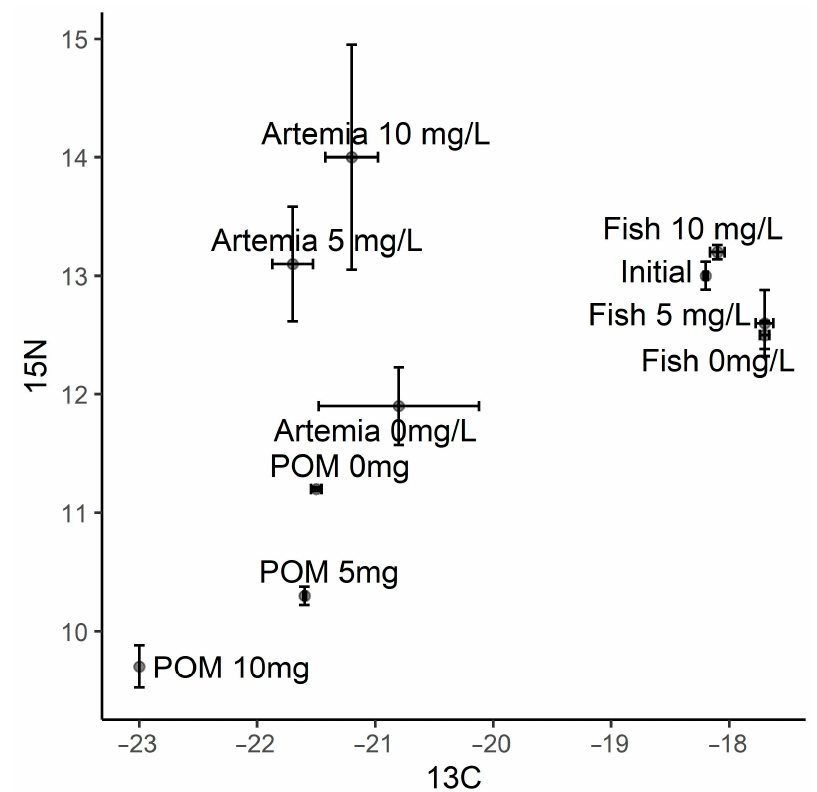
Figure 3. δ 13C (13C) and δ 15N (15N) stable isotope ratios for fish tissues at the beginning (Initial) and conclusion of the experiment for all 3 treatments (Fish 0 mg/L, Fish 5 mg/L and Fish 10 mg/L). Isotopic ratios are also displayed for particulate organic matter samples from the Artemia on-growing tanks (POM 0 mg/L, 5 mg/L and 10 mg/L) and gut purged Artemia (Artemia 0 mg/L, 5 mg/L and 10 mg/L) from the 3 treatments. Error bars represent standard error of the mean for each sample.